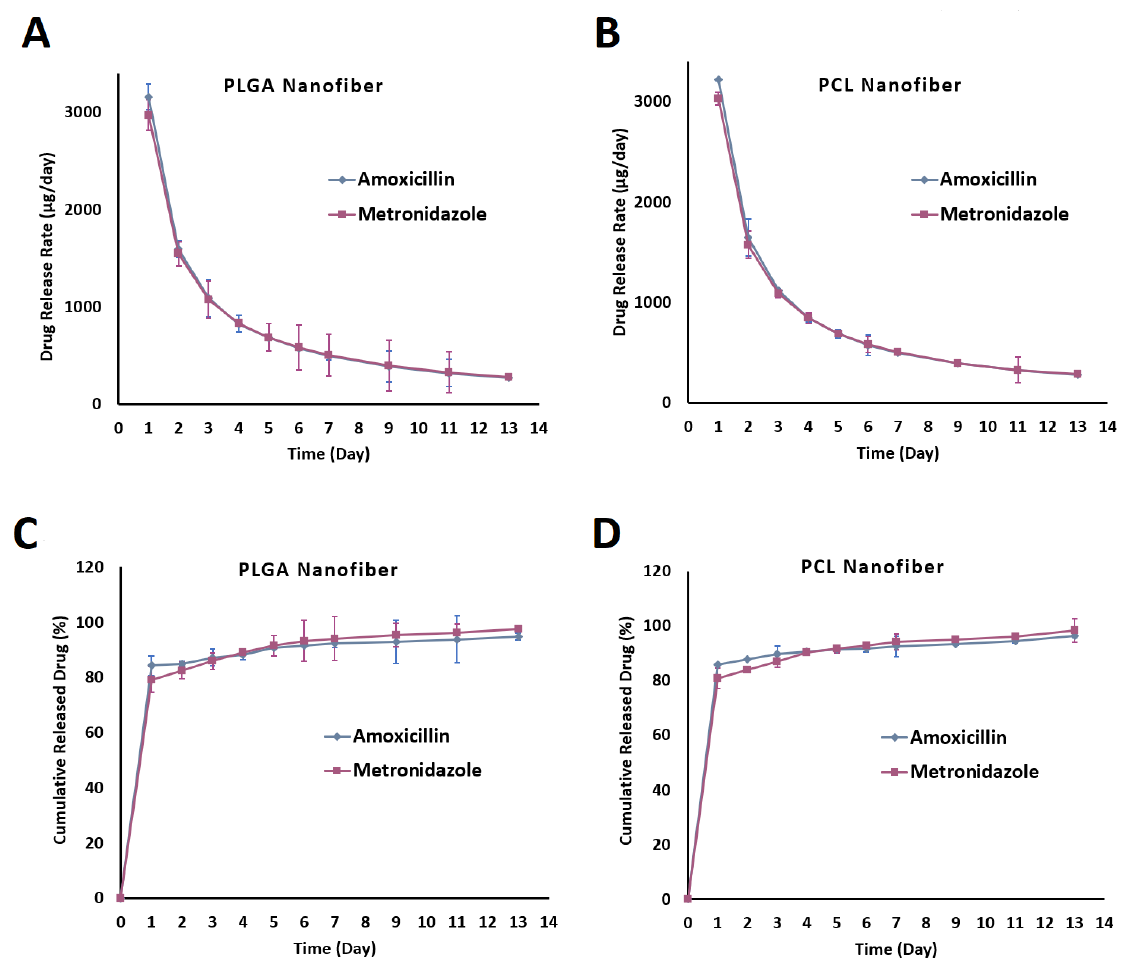
Figure 7. Drug release rate (µg/day) from PLGA ( A ) and PCL ( B ) nanofibers and cumulative percentages of released drugs from PLGA ( C ) and PCL ( D ) nanofibers in the subcutaneous tissue of rats during the in vivo study.